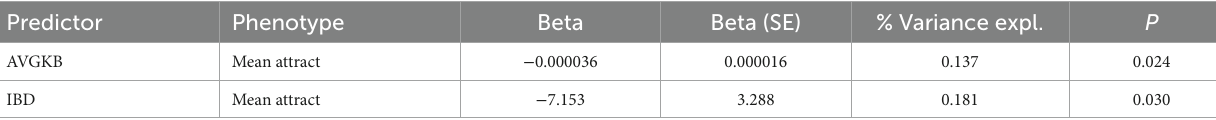
Values for non-significant indicators and covariates are not